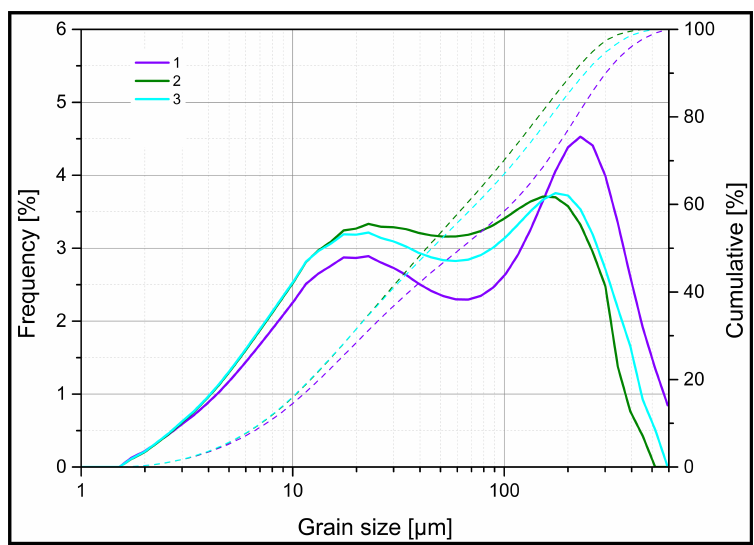
Figure 1. Grain size distribution for laboratory